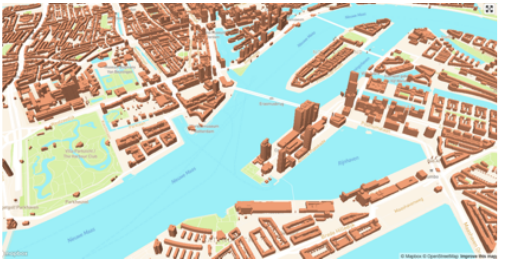
Figure 3: Visualisation of reconstructed LoD1.3 buildings